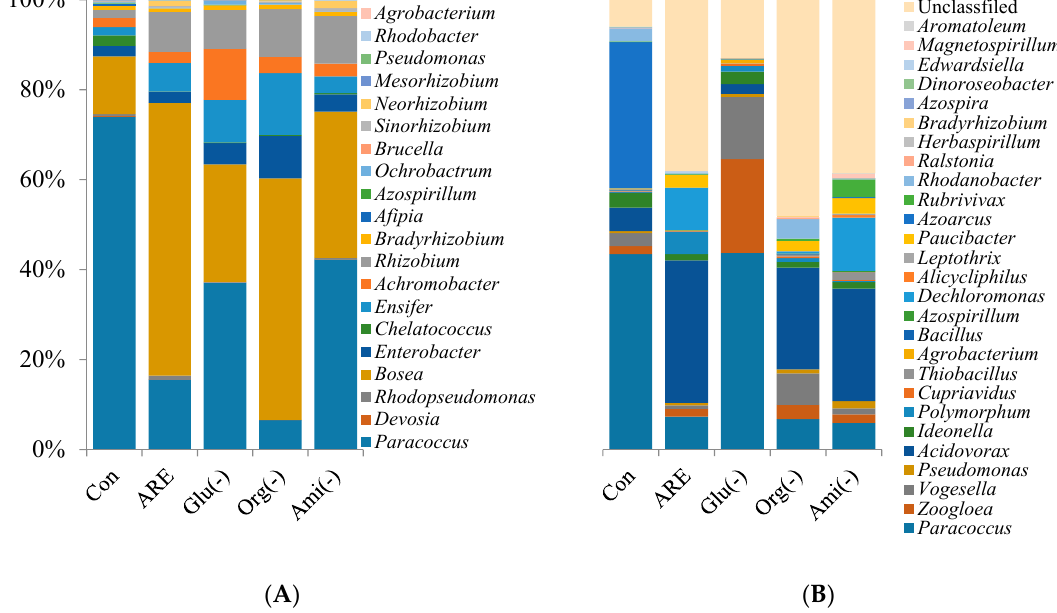
Figure 2. The community composition of ( A ) nirK -encoding denitrifying bacteria and ( B ) nirS -encoding denitrifying bacteria at genus level in CWs.